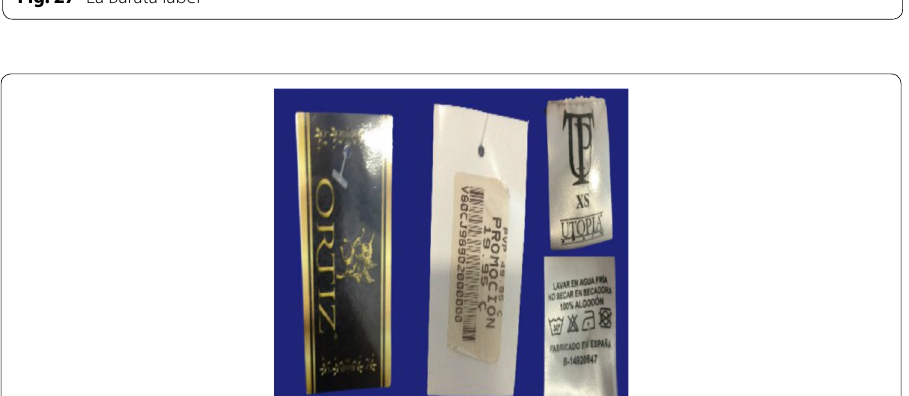
Fig. 27 La Barata label